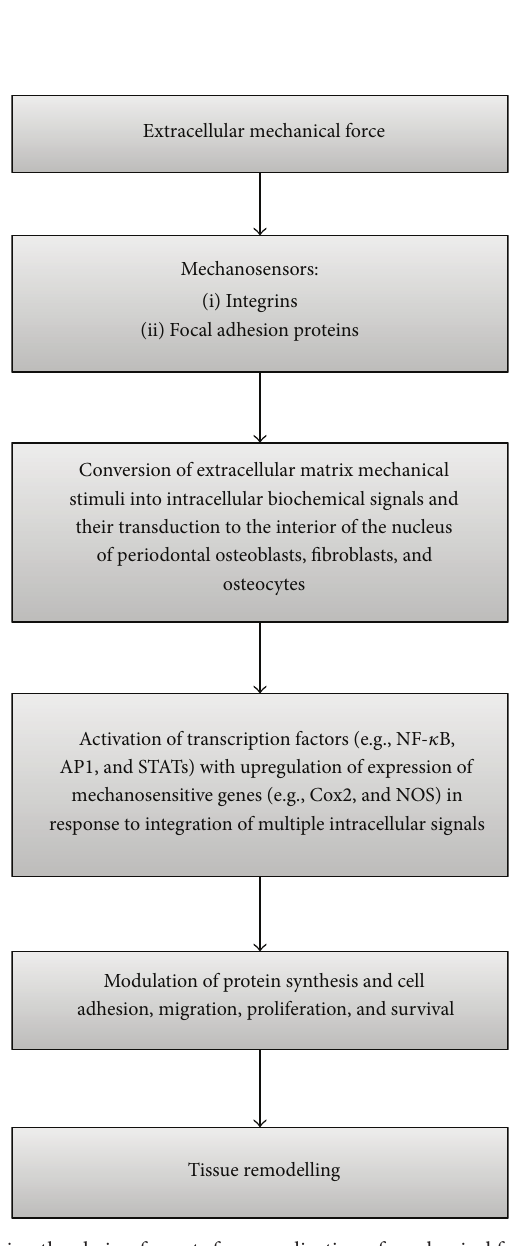
Figure 2: Flowchart showing the chain of events from application of mechanical forces to tissue